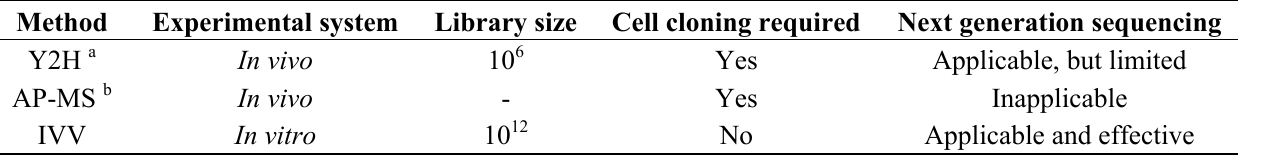
Table 1. Comparison of comprehensive protein–protein interaction analysis